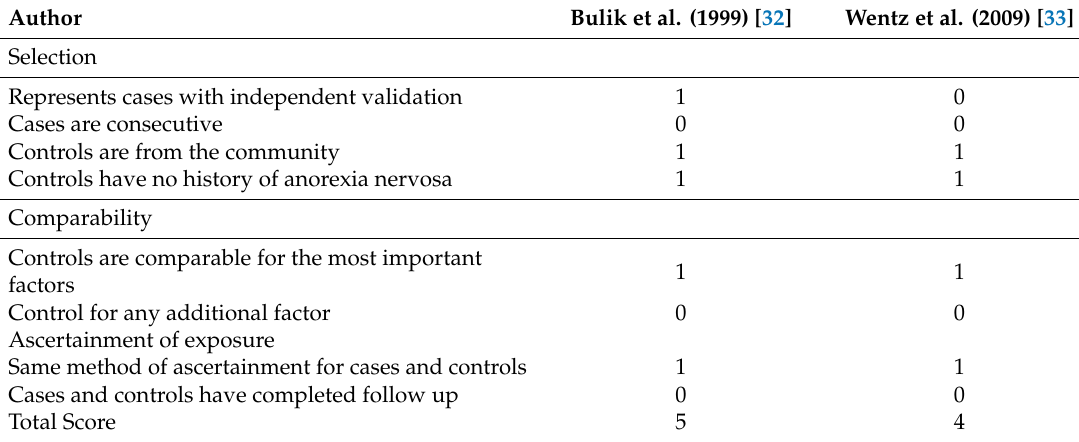
Table 3. Newcastle-Ottawa Scale (NOS) quality assessment